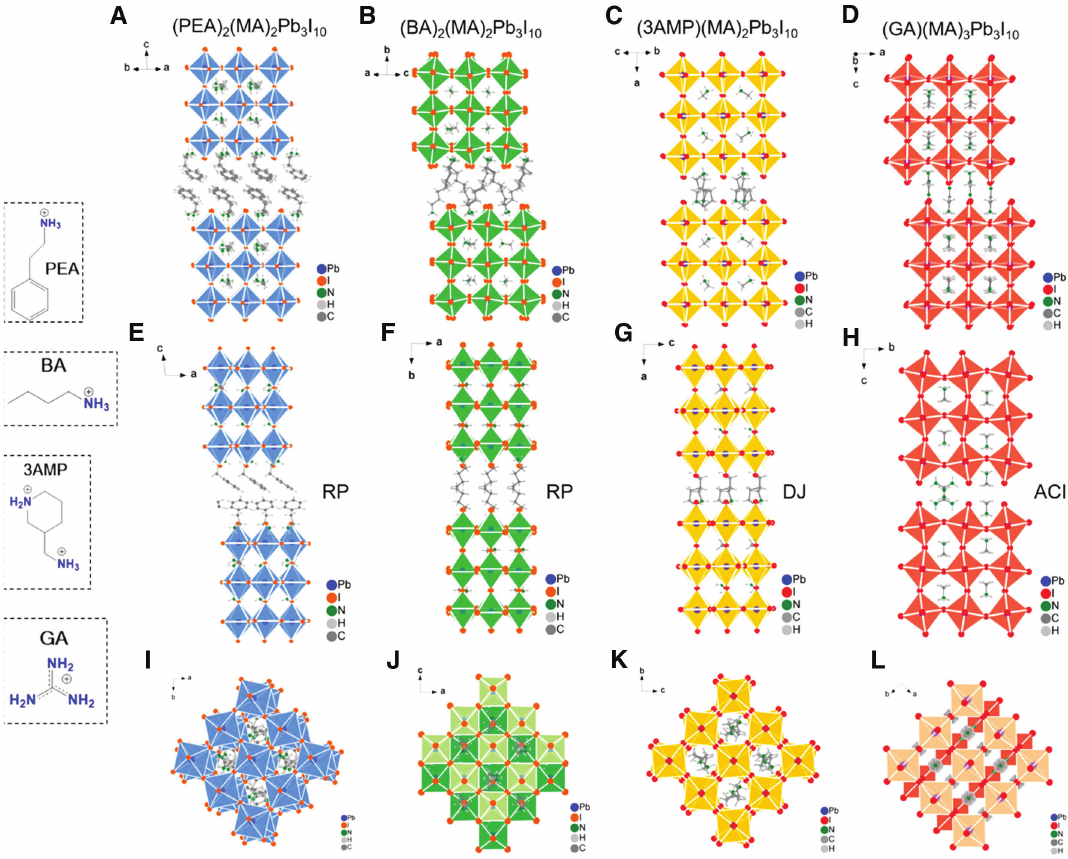
Figure 3: Structural comparison among the n = 3 crystal structures of the R-P phase, D-J phase, and ACI phase 2D perovskites. (A, E, I) (PEA) permission from the American Chemical